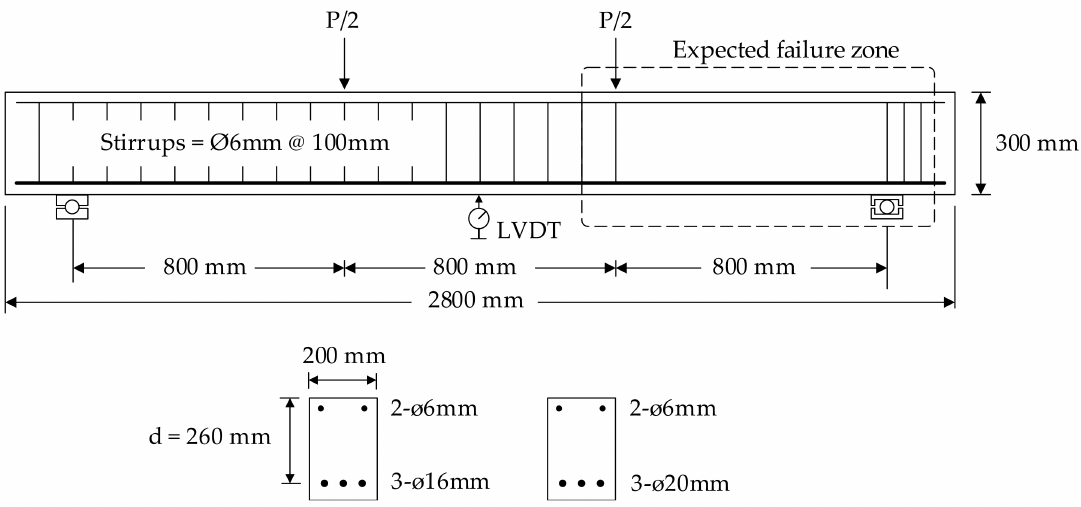
Figure 2. Test setup and details of beam specimens.